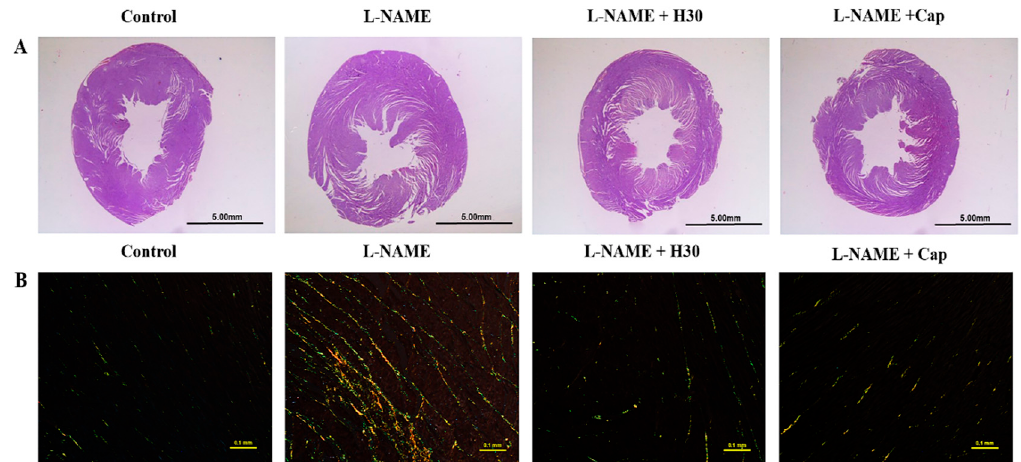
Figure 2. The histology and morphology of LV from control, L -NAME, L -NAME + hesperidin (30 mg/kg) and L -NAME + captopril (2.5 mg/kg) groups. Representative images of LV sections, ( A ) stained with hematoxylin and eosin under stereomicroscopes, and ( B ) stained with picrosirius red under a polarized light microscope using a 20× objective lens. Table 2. Effect of hesperidin and captopril on the cardiac mass indices and cardiovascular structural modifications in left ventricle and thoracic aorta.